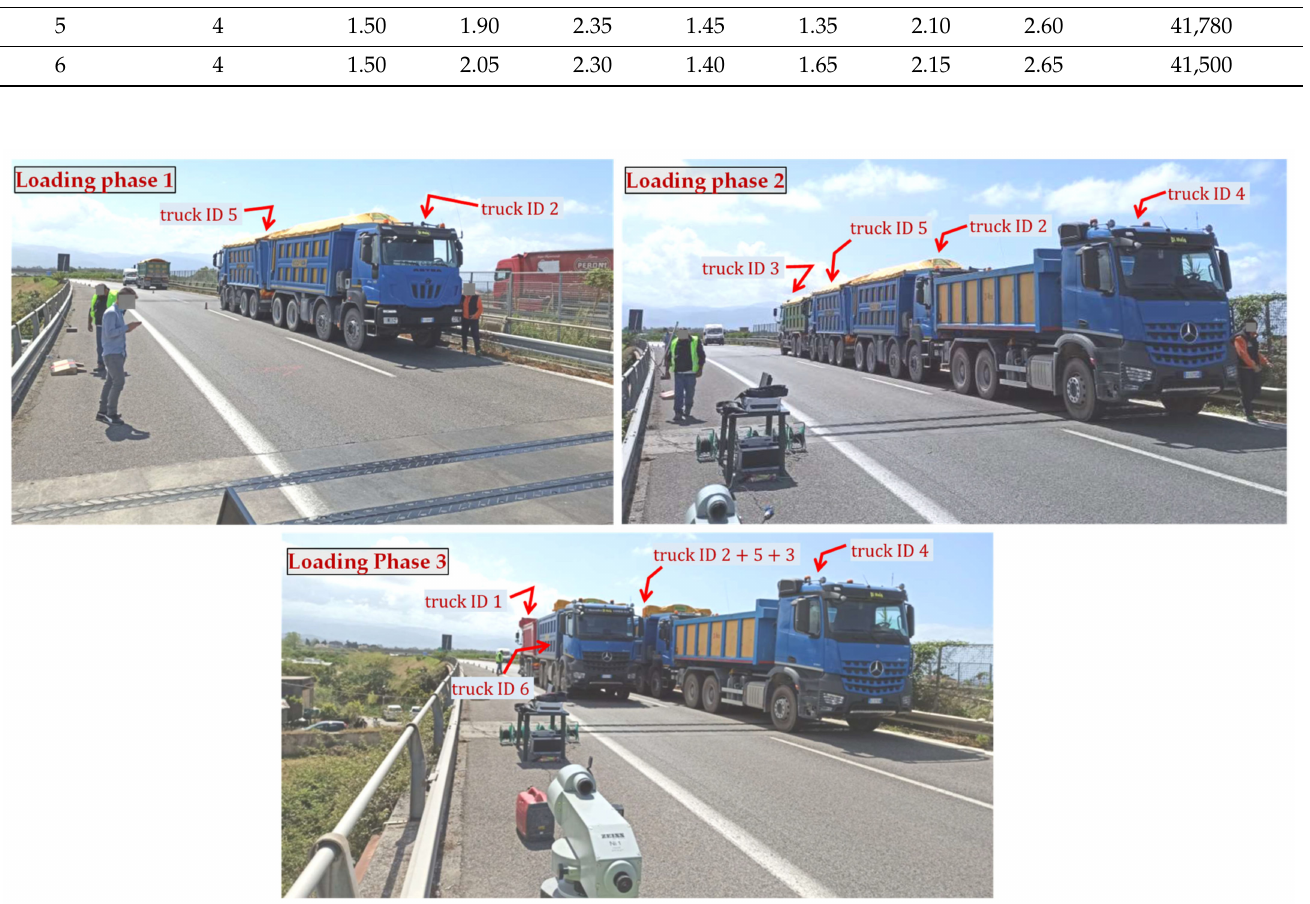
Figure 14. Photographs of static load tests in three subsequent phases for the roadway from Palermo to